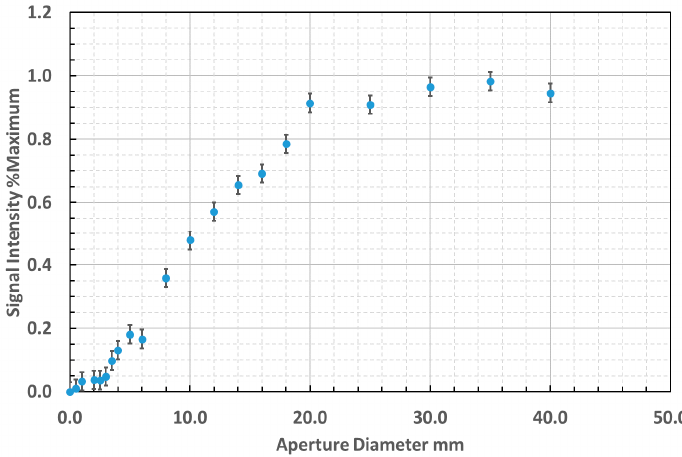
Figure 9. Field of view measurement with aperture positioned at 68 mm from fiber optic cable.